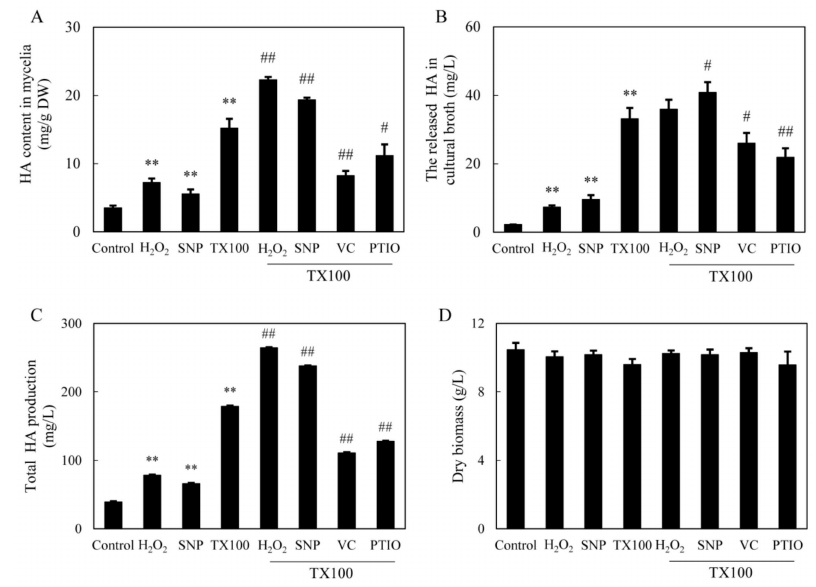
Figure 6. E ff ects of TX100 on HA content in mycelia ( A ), the released HA in medium ( B ) and total HA production ( C ) and mycelium biomass ( D ), and the influences of the donor, inhibitors and scavengers (same dosage as specified in Figures 3 and 4) of NO and ROS in the extractive fermentation. TX100 was added at 25 g / L at 36 h of the 8-day fermentation. Values are mean ± SD from three independent